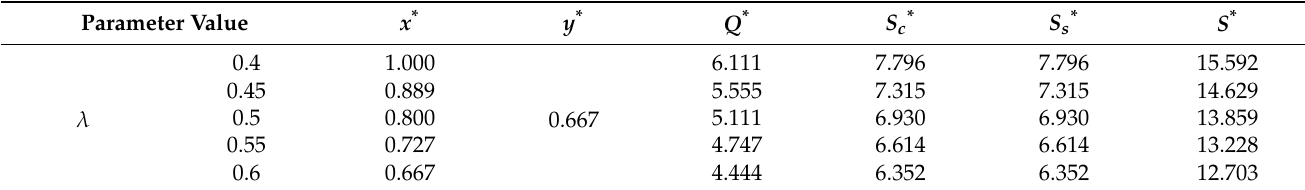
Table 5. Effect of quality cost factor λ on equilibrium solution.